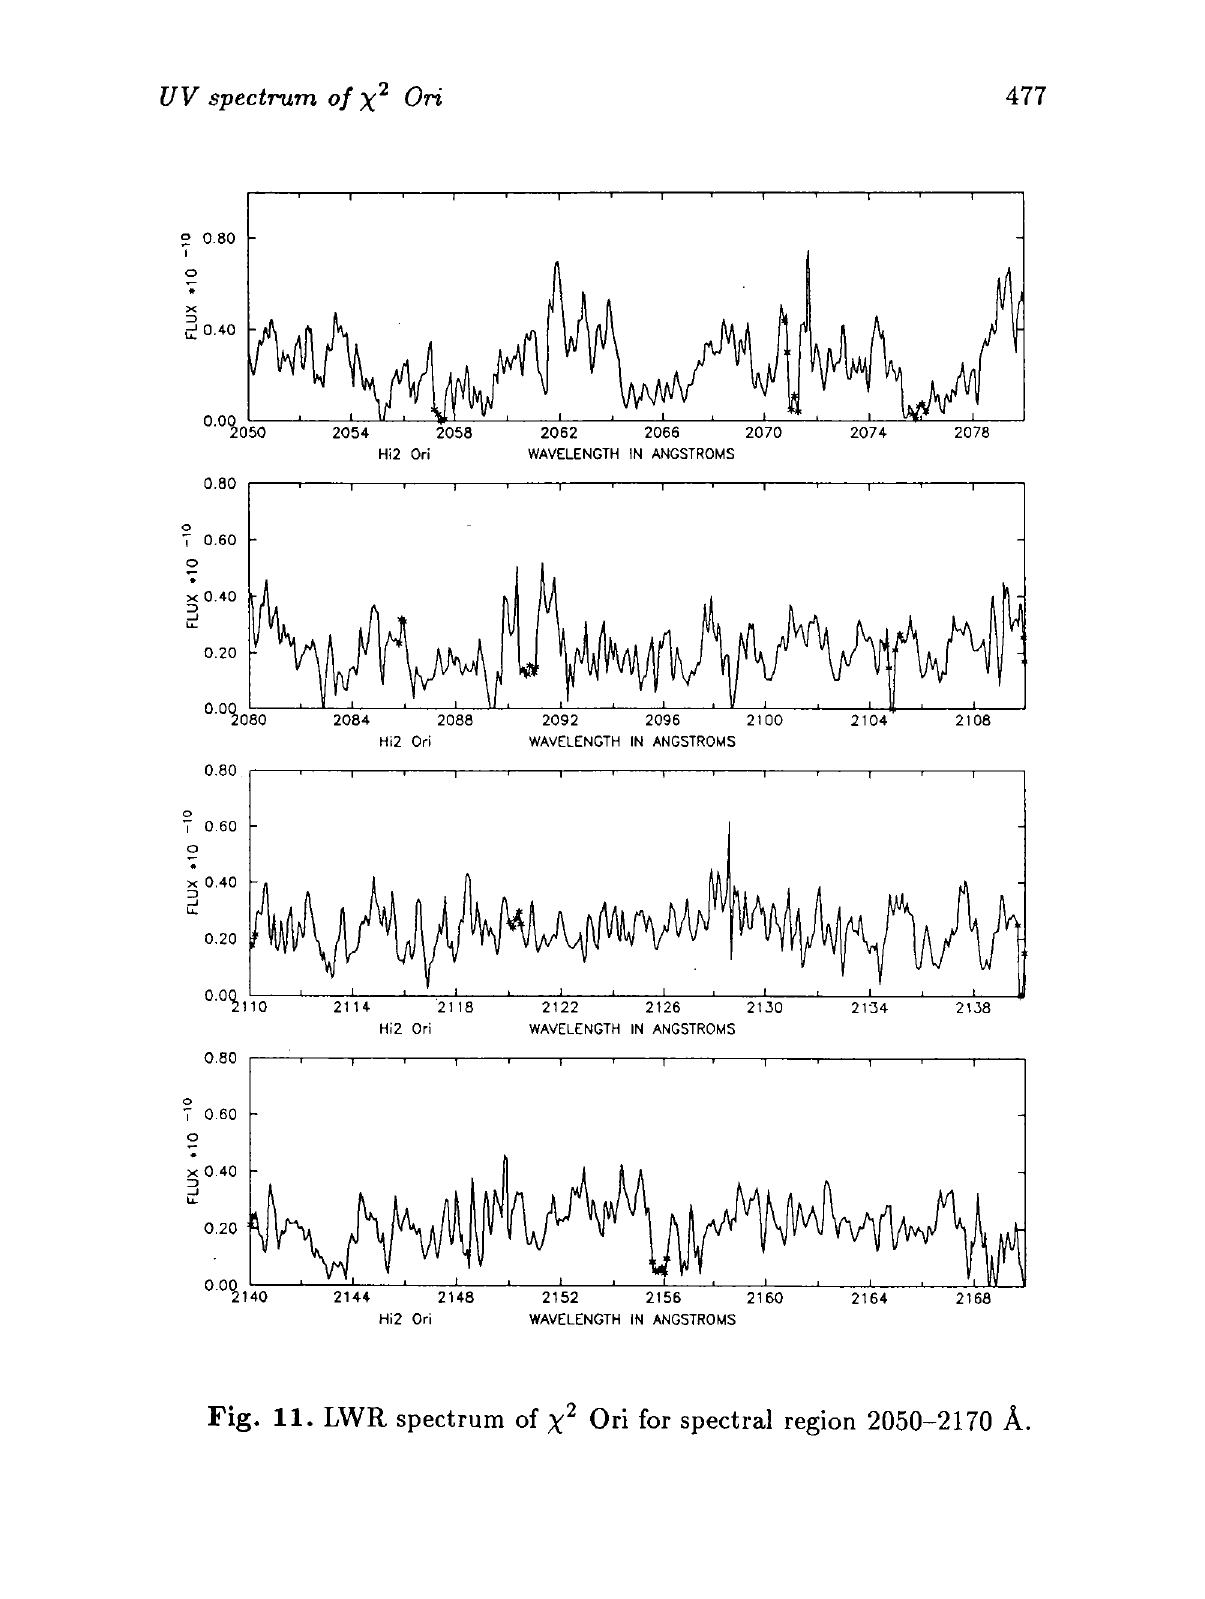
Fig. 11. LWR spectrum of x 2 Ori for spectral region 2050-2170